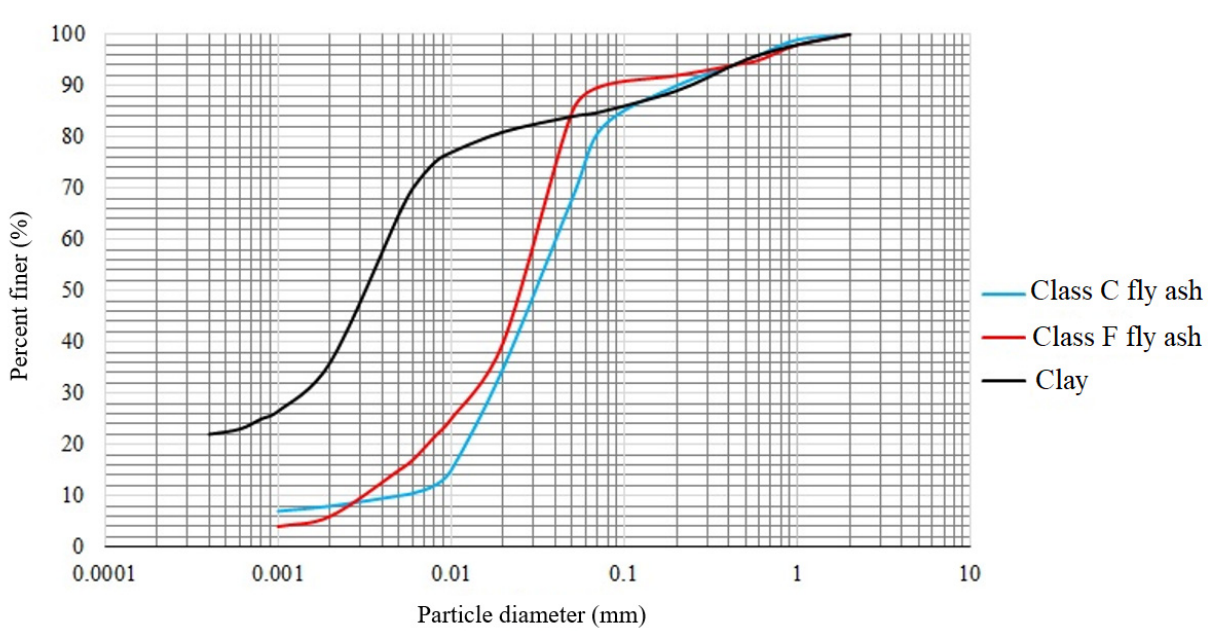
Figure 1. Clay and fly ash soil grading curves.